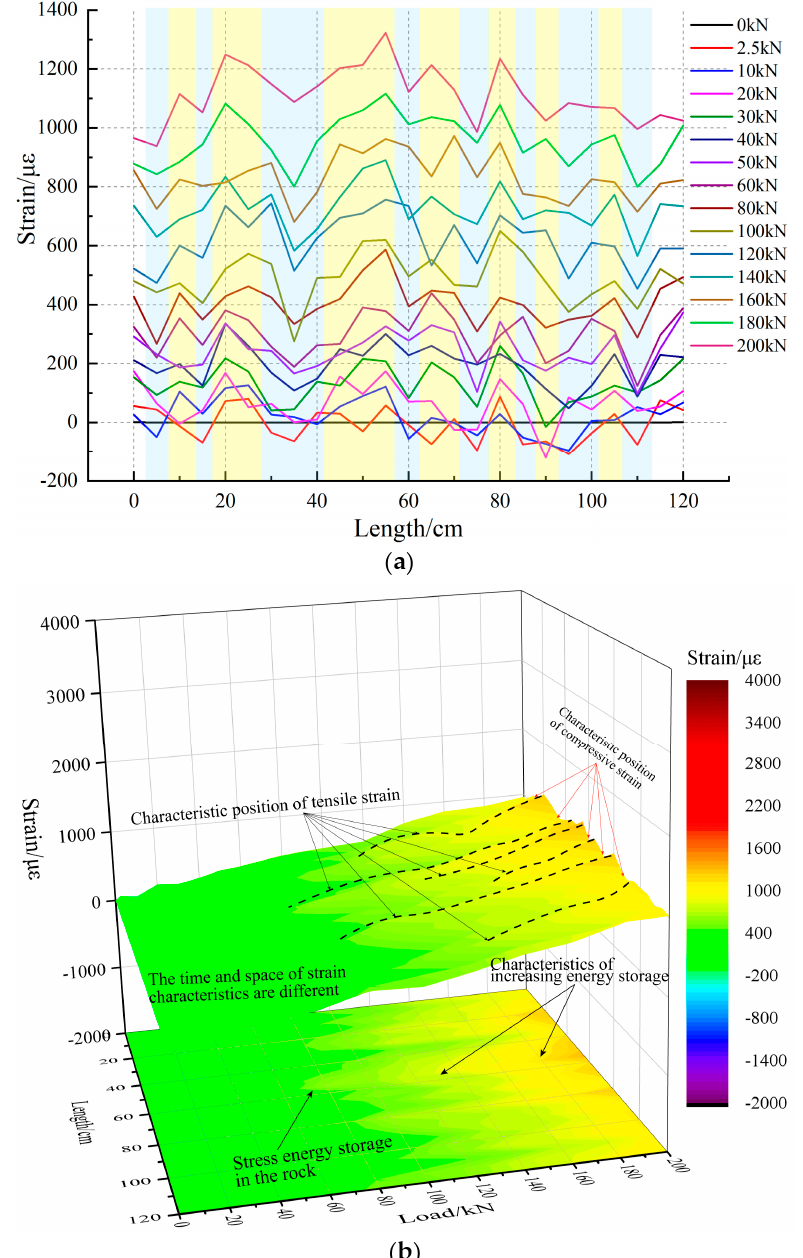
Figure 6. Distributed optical fiber test results of 0# rock sample surface strain; ( a ) shows the fiber optic strain for loading line length of No.0 rock sample; ( b ) shows the strain time–space nephogram of No.0 rock sample.